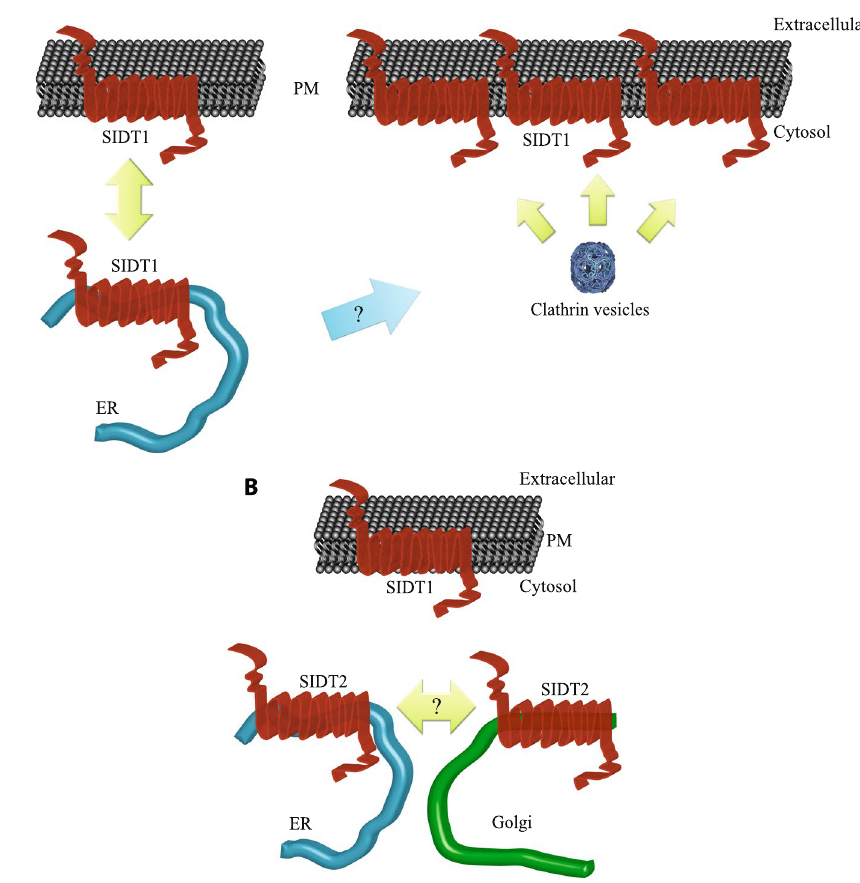
Figure 7. Cartoon illustrating the model proposed for cholesterol transport mediated by SIDT1 and SIDT2. ( A ) Under normal cholesterol plasma membrane levels, SIDT1 is present in the plasma membrane and endoplasmic reticulum. Upon reduction of plasma membrane cholesterol with M β CD, SIDT1 moves to the plasma membrane by a clathrin-dependent mechanism. This newly incorporated SIDT1 may come from the endoplasmic reticulum or vesicles located near the plasma membrane. ( B ) While SIDT1 is present in the plasma membrane, SIDT2 is found primarily in the endoplasmic reticulum and the Golgi apparatus. SIDT2 may be involved in the transport of cholesterol between these two